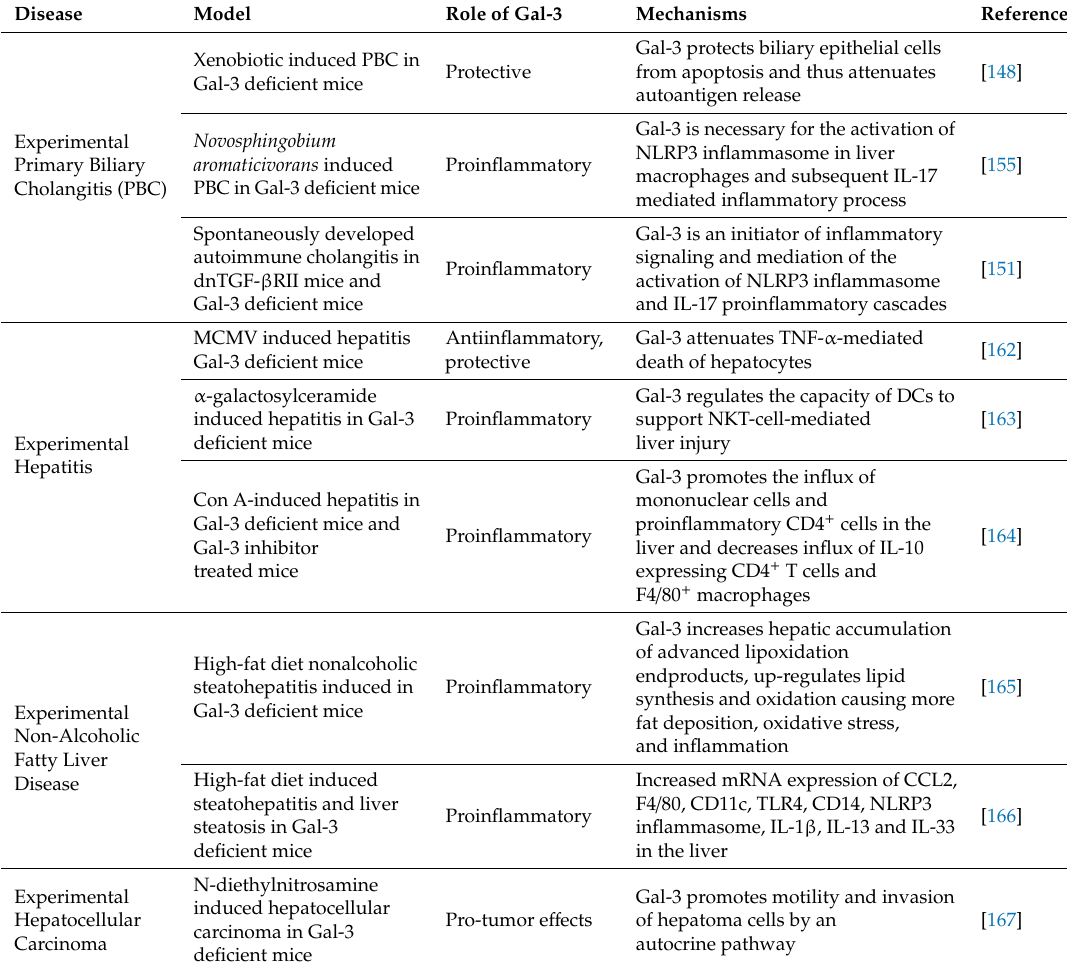
Table 1. Immunoregulatory role of galectin-3 in inflammatory and malignant liver diseases. Disease Model Role of Gal-3